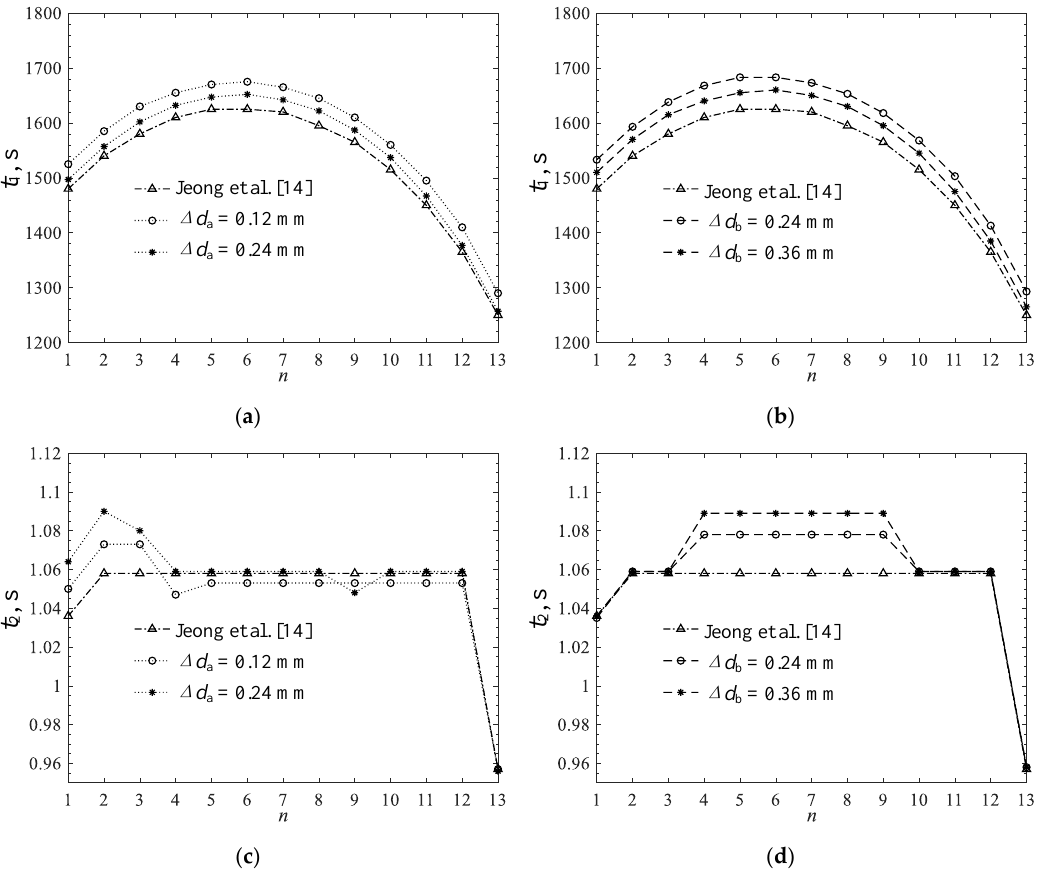
Figure 6. The influence of the thickness on the time corresponding to the initial solidification of each layer electrolyte for: ( a ) group a , and ( b ) group b heat pellets on the; the influence of the thickness on the time of complete melting of each layer electrolyte for: ( c ) group a , and ( d ) group b heat